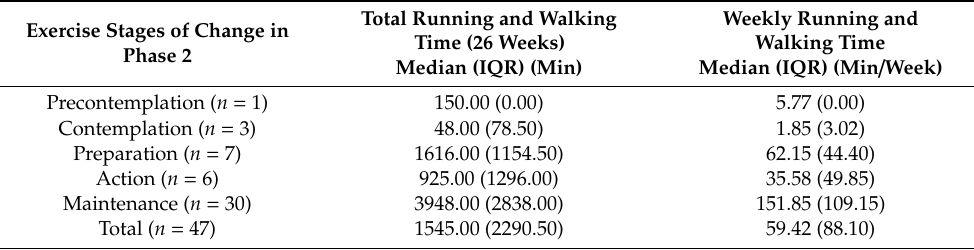
Table 4. Running and walking time by exercise stages of